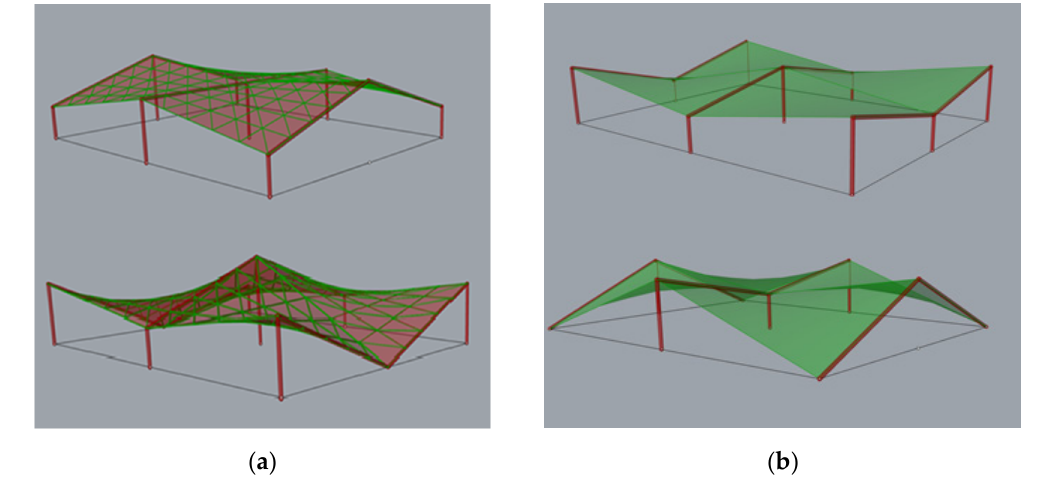
Figure 11. Examples of multi-segment structures composed of hyperbolic paraboloid units ( a ) with lattice roof and ( b ) with steel sheets roofing.